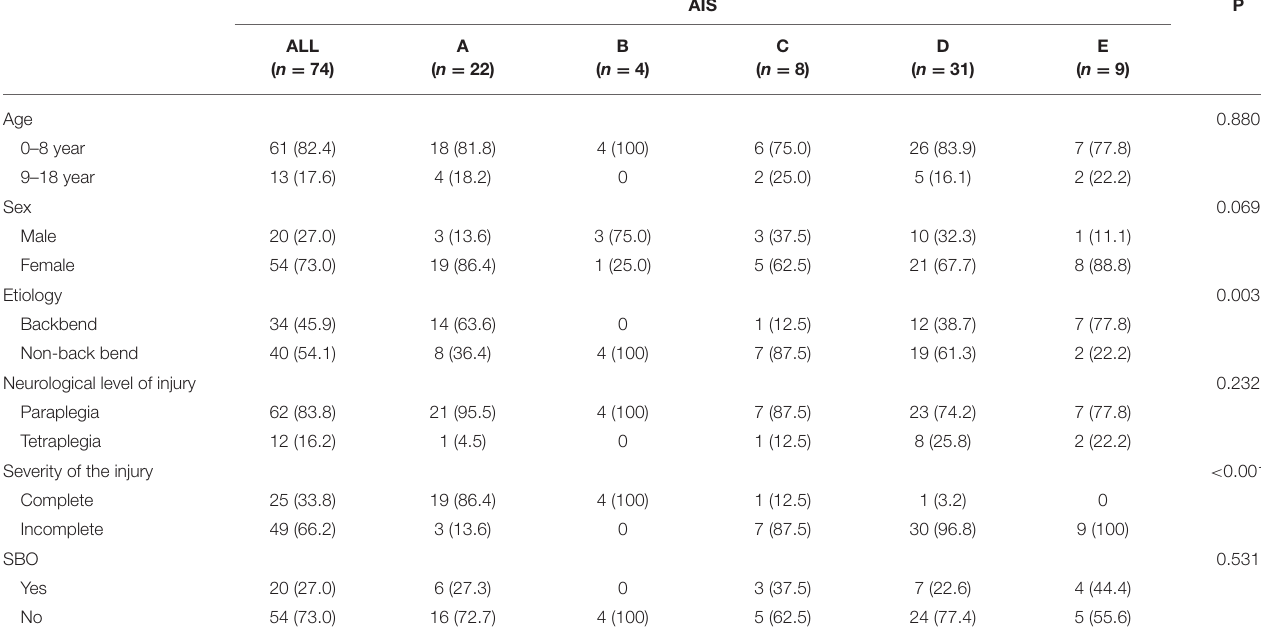
TABLE 4 | Progression at last